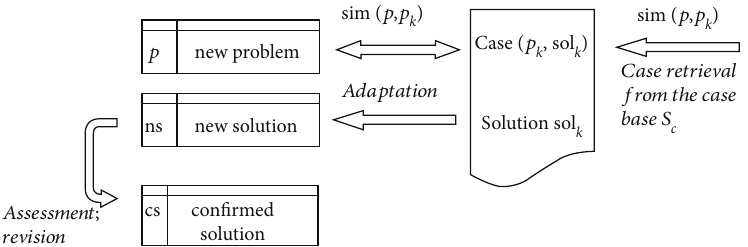
Figure 1: The CBR